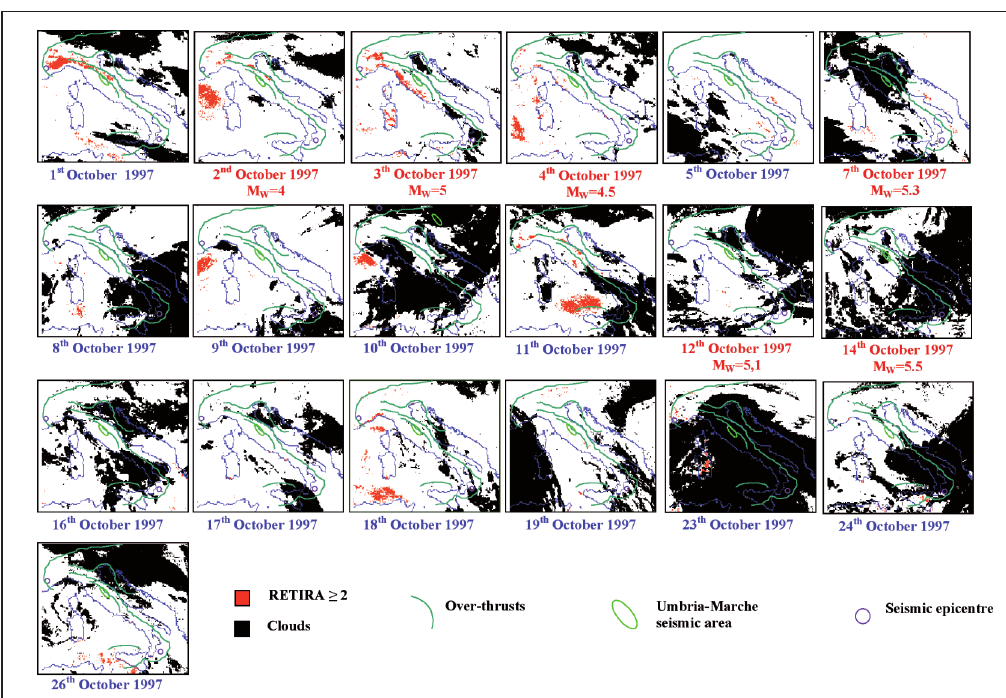
Fig. 2. Validation: results of the RETIRA index computation on the investigated area (see text). Overcast scenes and images which are affected by navigation errors are not shown. The datas of Umbria-Marche earth- quakes, together with their magnitude, are reported in